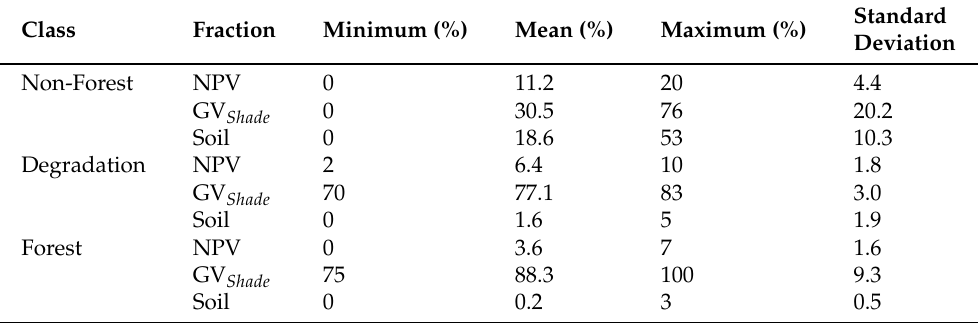
Figure 7. Fraction image composition of Forest , Degradation , and Non-Forest pixels, plotted in a ternary diagram. Vertices represent fractions of endmember NPV, GV Shade , and Soil, where in ( a ) the entire fractions of endmembers and in ( b ) a zoomed-in section of endmembers NPV (0–20%), GV Shade (70–100%), and Soil (0–20%) are shown. Table 3. Class statistics as used within the plausibility analysis, extracted from 494 random se- lected